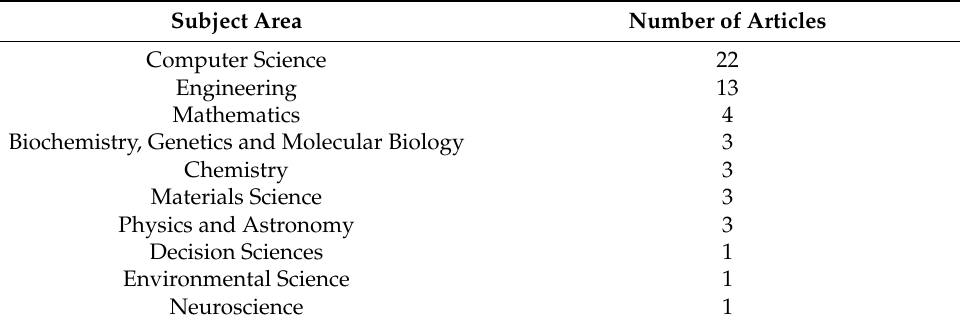
Table 2. Number of articles based on the subject area.